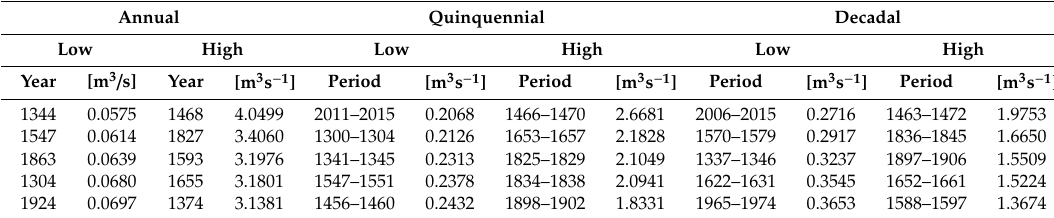
Figure 2. Annual streamflow reconstruction of Sobrante River using tree-ring records. ( a ) Calibration period of the reconstruction model, ( b ) Cycles found in the reconstruction using Multi-Taper Method (MTM) analysis, ( c ) Streamflow reconstruction (1300–2017) of the Sobrante river and its percentiles representations in colors over the reconstruction. The grey band indicates the standard error (SE) as measures of uncertainty. The variance explained was evaluated by the R 2 adjusted = 0.562. The model skills was tested by the Reduction Error RE = 0.53, and the residuals of the regression models are normally distributed and not significantly autocorrelated, according to Durbin-Watson tests DW = 1.97. Table 3. Ranking of the five extreme annual, 5 year and 10 year periods of low and high streamflow for the Sobrante river streamflow